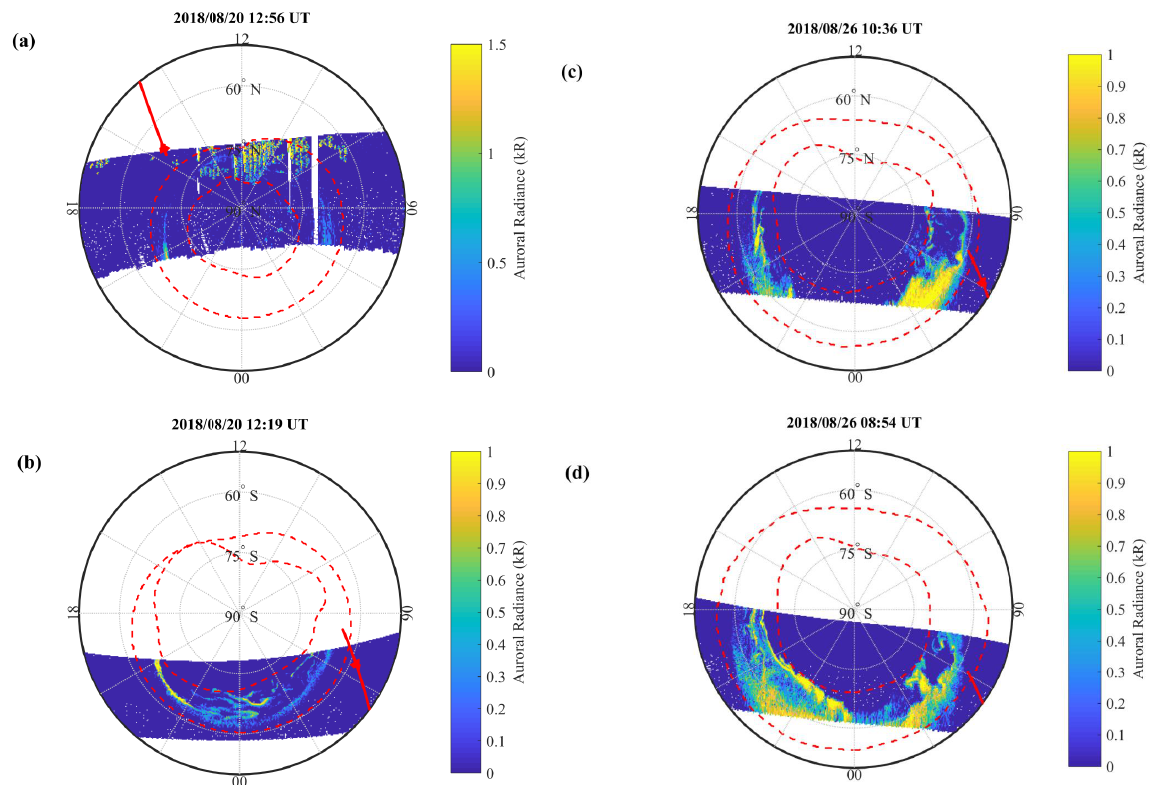
Figure 8. The auroral ultraviolet images by the SSUSI instrument on board the DMSP satellite. Panel ( a ) refers to the quiet Northern Hemisphere observations; Panel ( b ) refers to the quiet Southern Hemisphere observations; Panel ( c ) refers to the stormy Northern Hemisphere observations; Panel ( d ) refers to the stormy Southern Hemisphere observations; the red dashed curves refer to the upper and lower boundaries of the auroral oval. The red curve refers to CSES-01’s orbit. The selected reference is the Altitude Adjusted Corrected Geomagnetic (AACGM) coordinate